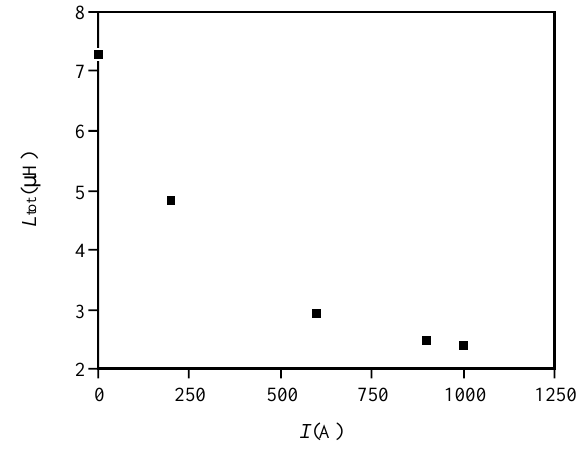
FIG. 9. Dependence of summed inductance of the two cavities on bias current.